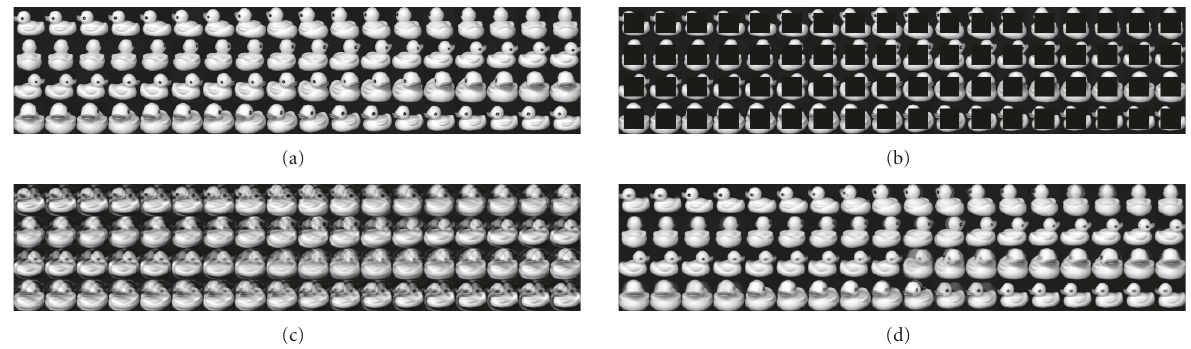
Figure 6: The 72 images of the duck set of the COIL-20 database with (a) 0% and (b) 40% occlusion; (c) reconstruction from PCA-15 compression, (d) reconstruction from S P -2 compression. The occlusion percentage is measured with respect to the entire image and would be larger if measured with respect to the